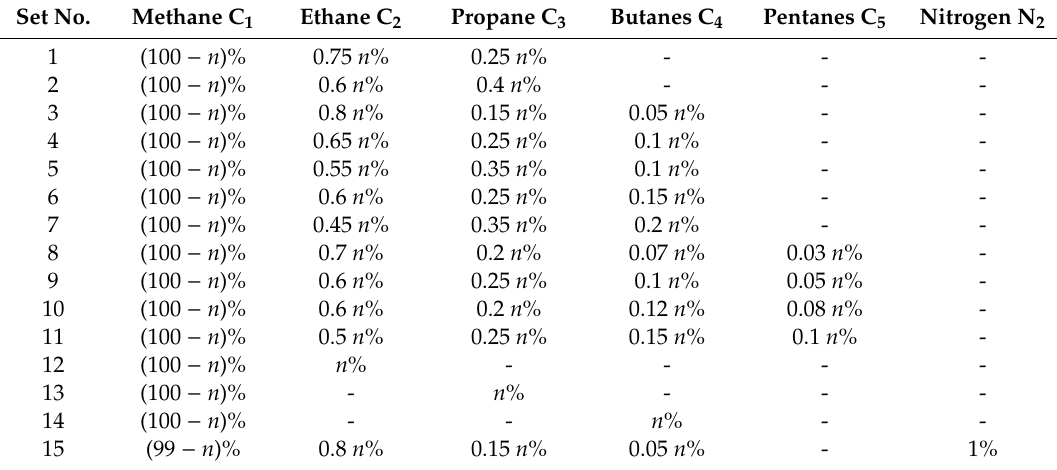
Table 5. Assumed sets of liquefied natural gas compositions (molar